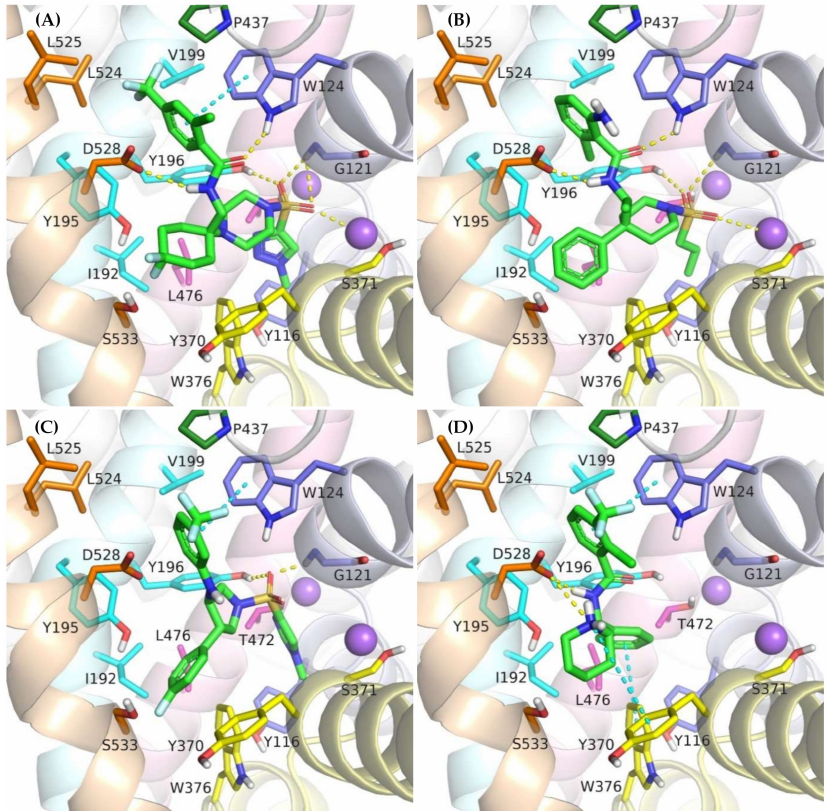
Figure 7. Binding mode of the competitive GlyT-1 inhibitors within the transporter in the outward- open state: compound 2 ( A ); ACPPB ( B ); compound 3 ( C ); SSR-504734 ( D